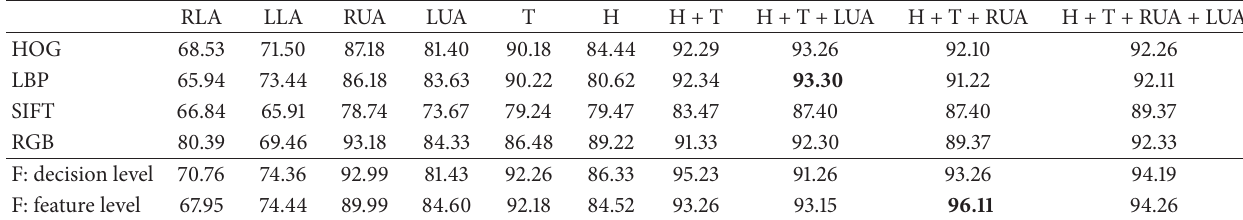
Table 3: Automated gender recognition accuracies (%) on